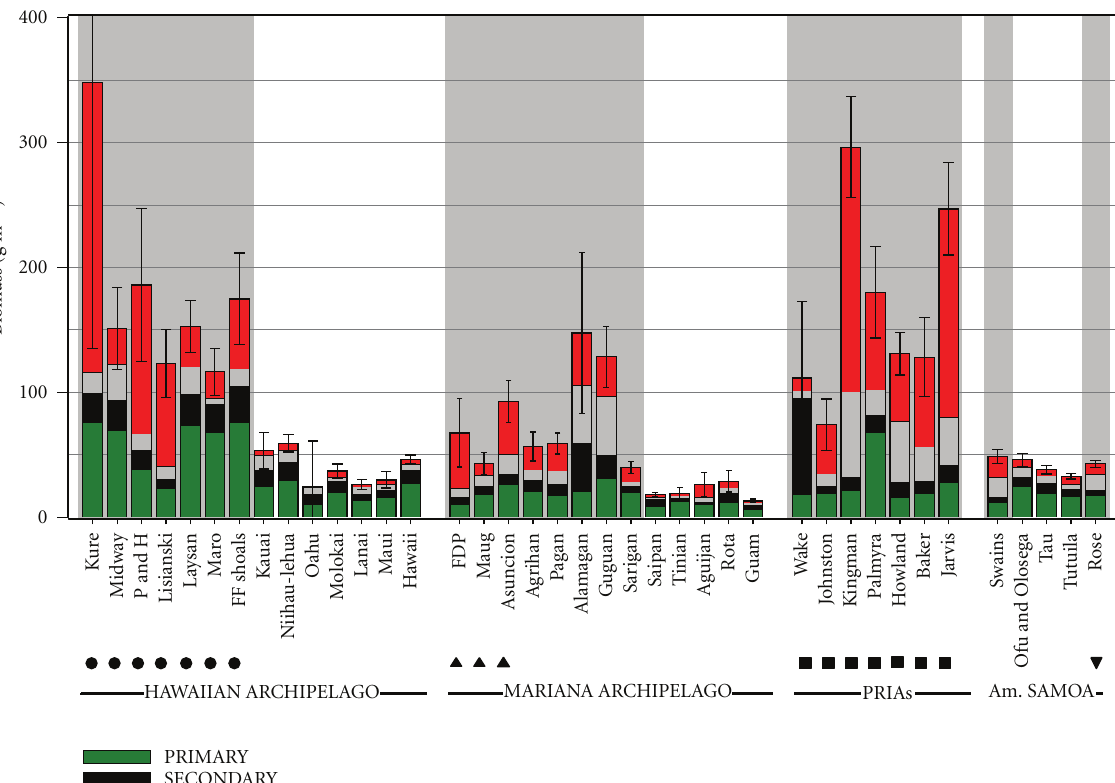
Figure 2: Mean biomass per reef-area by trophic grouping. Vertical bars indicate ± 1 SE (for total biomass) with all fore reef sites per location as replicates. Reef-areas are grouped by region (Hawaiian and Mariana Archipelagos, PRIA, American Samoa). Within regions, reef-areas are ordered by latitude with most northerly reef-areas to the left. Shaded portions of the figures indicate “remote” reef-areas, as defined in Section 2. Reef-areas within Marine National Monuments (MNMs) are identified by circles for Papah¯anaumoku¯akea MNM; upright triangles for Mariana Trench MNM; squares for Pacific Remote Islands MNM; and inverted triangle for Rose Atoll MNM.